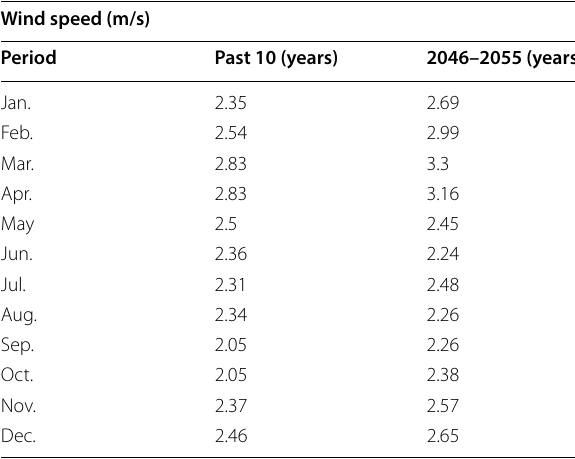
Table 7 Change in wind speed by RCP